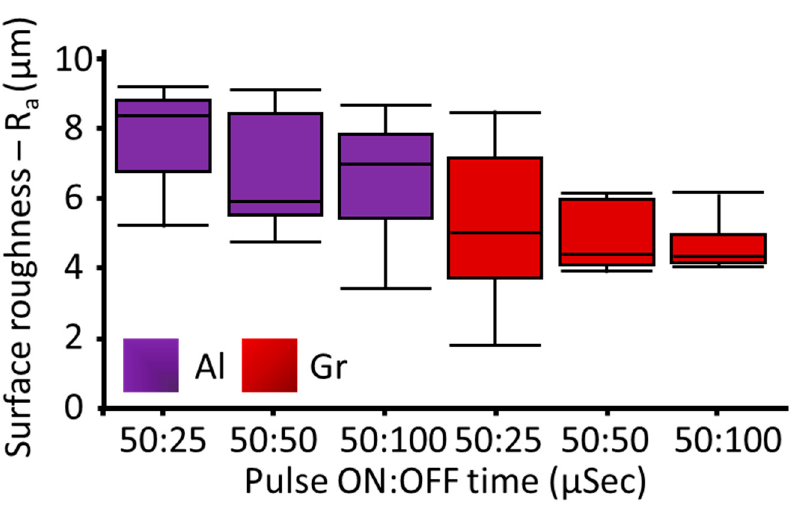
Figure 7. The parametric effect of cryogenic-treated electrodes and pulse ON:OFF time on surface roughness of surfactant-mixed dielectrics.